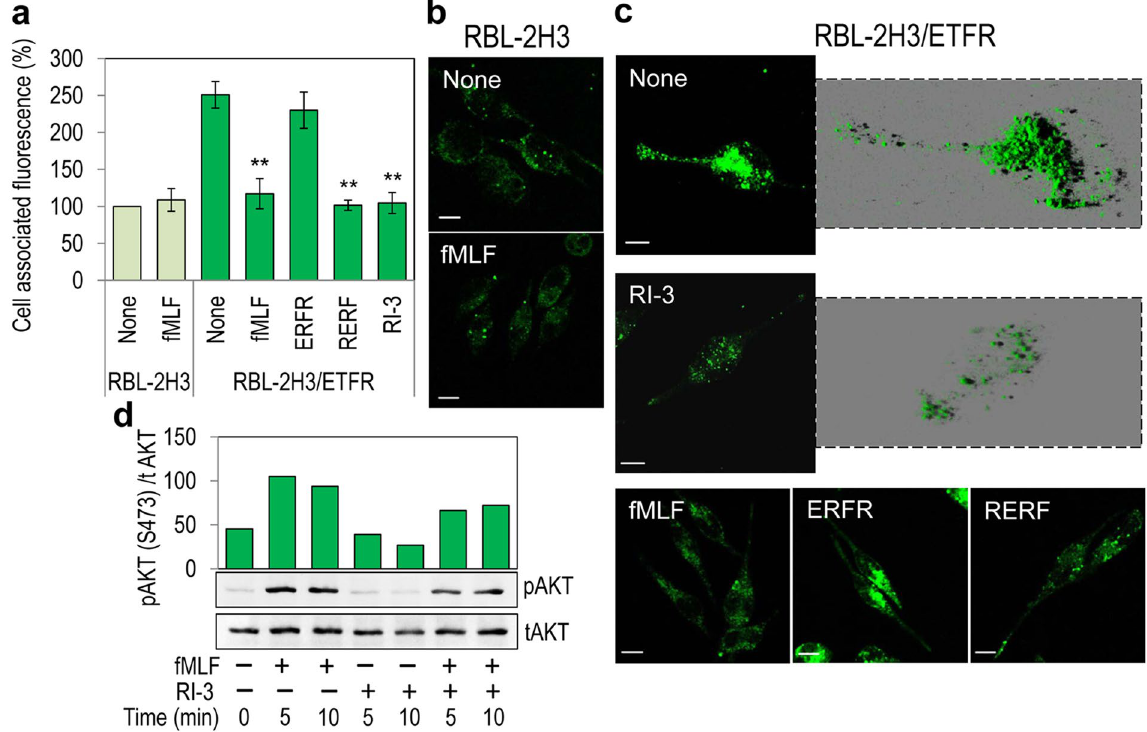
Figure 5. RI-3 blocks agonist/FPR1 interaction, agonist-induced FPR1 internalization and fMLF-dependent AKT phosphorylation. ( a ) RBL-2H3 and RBL-2H3/ETFR cells incubated with diluents (None), 100 nM fMLF, 100 nN RERF, 100 nM ERFR (scrambled peptide control) or 100 nM RI-3 for 60 min at 4 °C, were exposed to 10 nM FITC-fMLF for 60 min at 4 °C. Cell-associated fluorescence was measured using a fluorescence plate reader. Data expressed as a percentage of the fluorescence associated to RBL-2H3 cells exposed to FITC- fMLF alone, and considered as 100%, represent mean ± SD from three experiments performed in triplicate. ** Indicates statistical significance against RBL-2H3/ETFR cells exposed to FITC-fMLF alone with P = 0.001 . ( b , c ) Images of RBL-2H3 ( b ) and RBL-2H3/ETFR ( c ) cells incubated with diluents (None), 100 nM of the indicated peptides for 30 min at 37 °C, exposed to 10 nM FITC-fMLF for 30 min at 37 °C and then visualized using a Zeiss 510 Meta LSM microscope in 2D or 3D projections. Scale bar: 5 µ m. Original magnification: 630x. (d) Whole cell lysates from RBL-2H3/ETFR cells (50 µ g/sample) immunoblotted with anti-phospho-Akt (pAKT) Ab and then with total anti-Akt (AKT) mAb. The enclosed bar graph shows the average quantification of the pAKT content expressed as a percentage of total AKT. The uncropped images of selected immunoblots are shown in Supplementary Fig.